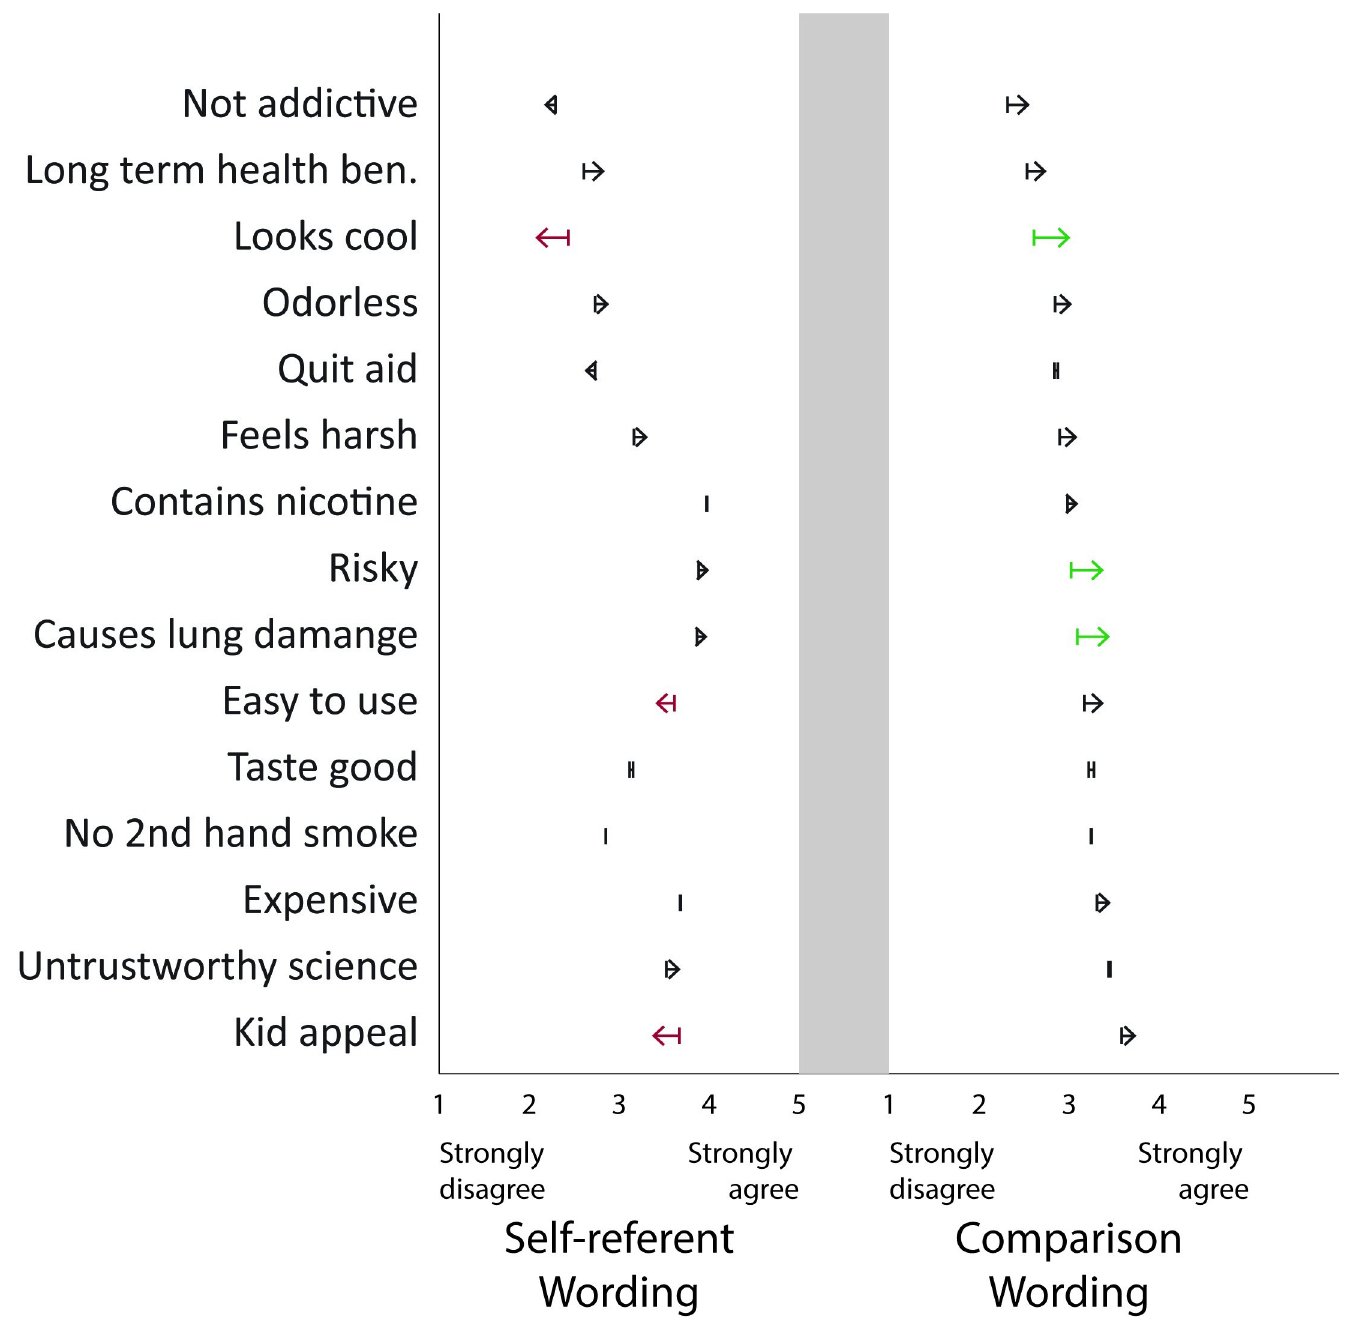
Fig 2. E-cigarette belief changes from study one to study two. A MANOVA indicated significant differences in beliefs from study one and study two. Bold arrows indicate the beliefs that were significantly different between study one and study two (p < .05). The grey bar separates the wording variations. https://doi.org/10.1371/journal.pone.0250908.g002 of the belief that using e-cigarettes was risky (m = 3.95, m = 4.4, p = .06, Hedges’ g unaware aware effect size = -.59; Table 4). There was no difference in endorsement between aware and